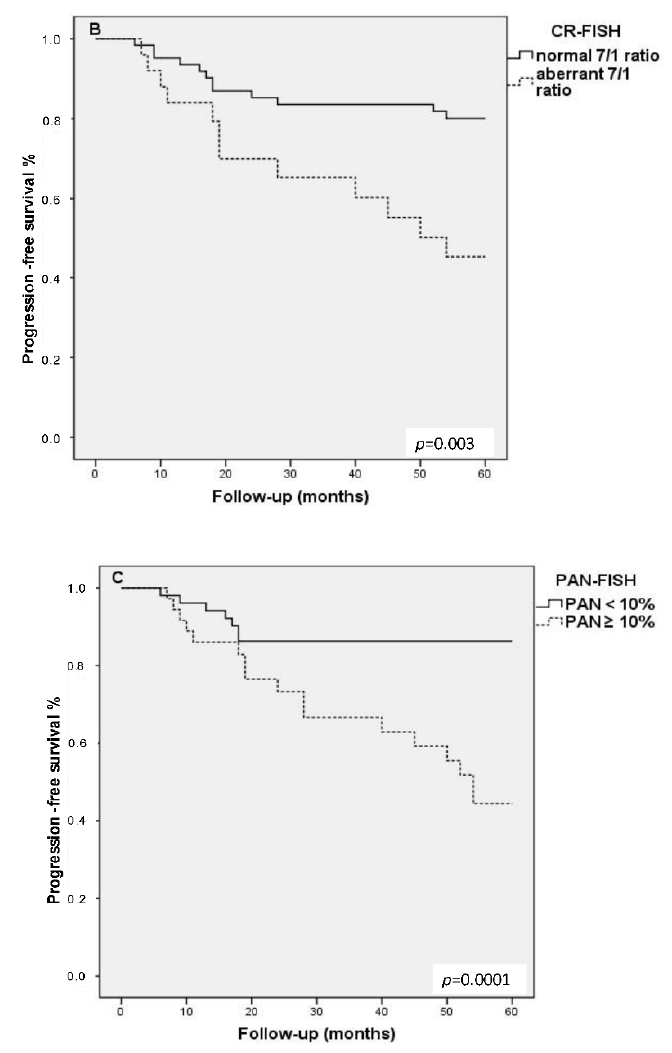
Figure 3. ( A – C ) Kaplan–Meier survival analyses for histopathology, CR-FISH, and PAN-FISH. ( A ) Progression-free survival according to histopathological diagnosis; patients with high-grade dysplasia show a significantly shortened progression-free survival as compared to the patients low grade dysplasia; ( p = 0.002). ( B ) Progression-free survival according to CR-FISH. Patients with an aberrant CR show a significantly shortened progression-free survival ( p = 0.003). ( C ) Progression- free survival according to PAN-FISH. Patients with PAN 10% show a significantly shortened ≥ progression-free survival ( p = 0.0001).